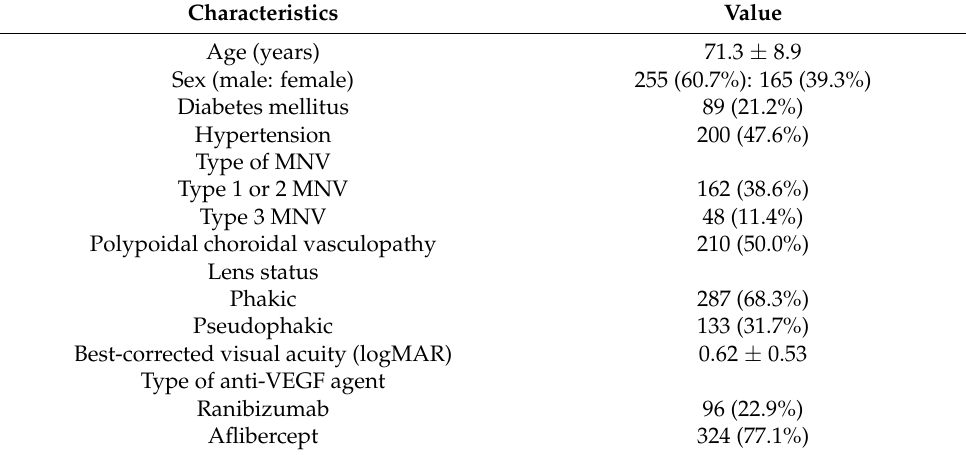
Table 1. Patient characteristics ( n =